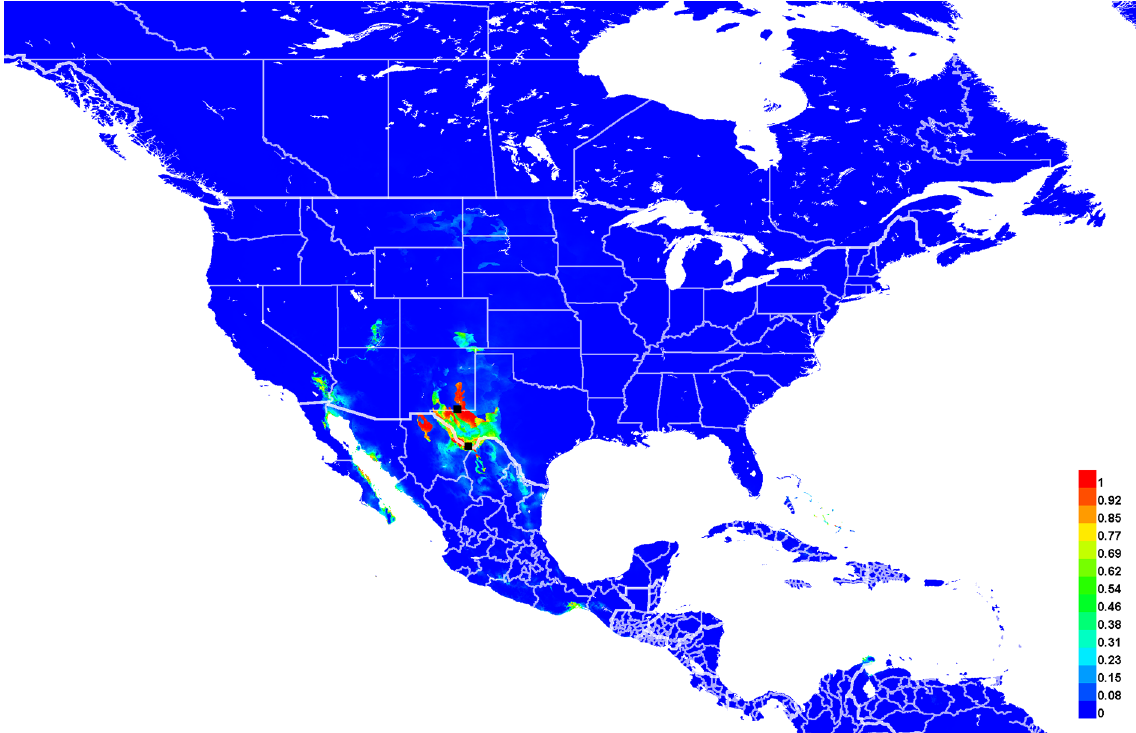
Fig. 72. Georeferenced collection records of Lasioglossum ( D. ) perditum sp. nov. (black squares) and predicted distribution by maximum entropy ecological niche modeling in Maxent (colour shading). Warmer colours indicate higher cloglog probability of occurrence. The predicted distribution was generated with a regularization multiplier of 0.5 to obtain a more conservative prediction. Due to the very small number of records, this distribution should be interpreted with